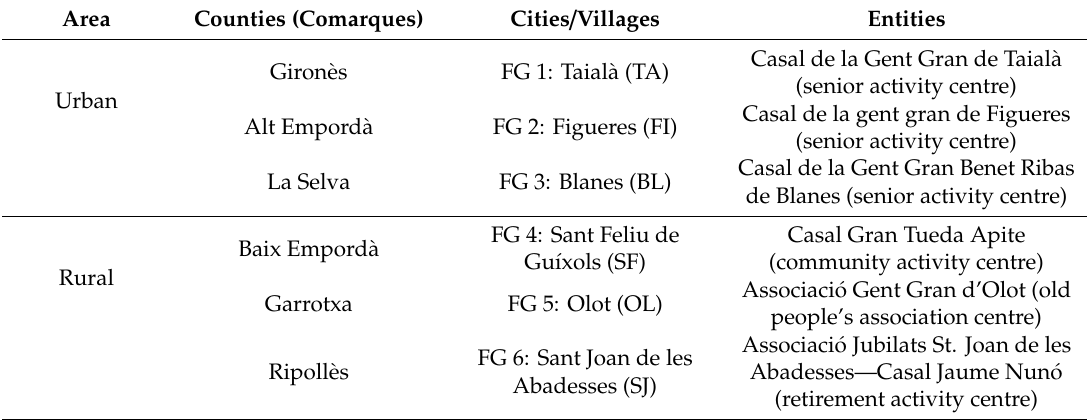
Table A1. Settings of the group sessions described according to the geographic location and the rural or urban environment